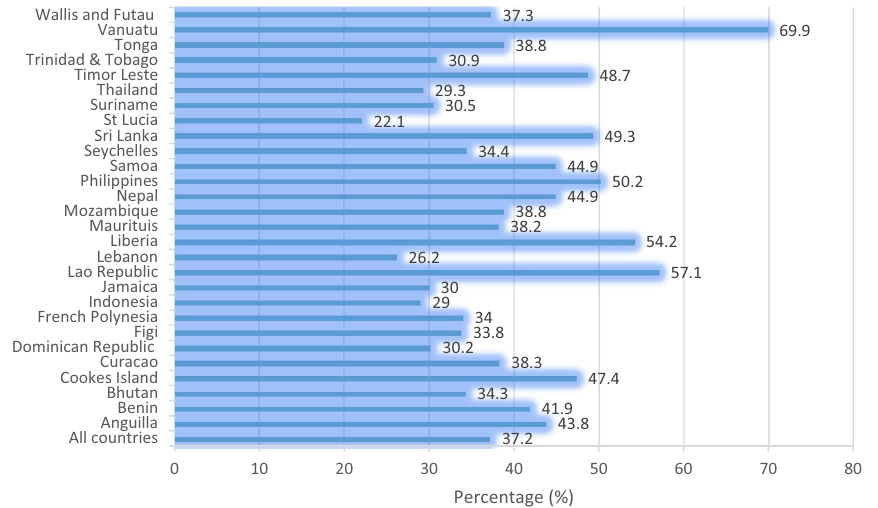
Figure 4. Prevalence of truancy across the 28 countries and territories.